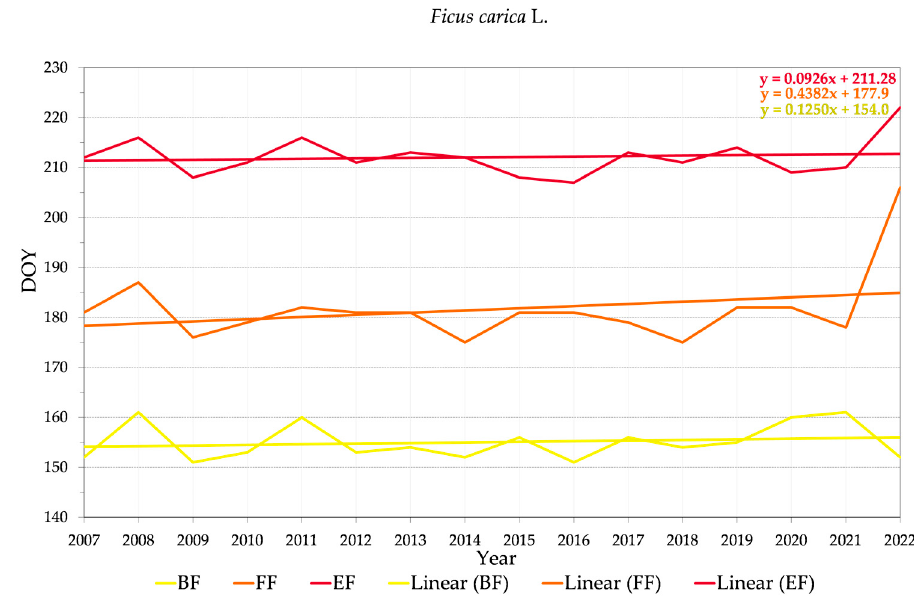
Figure 5. Linear trends of observed phenological stages for DOY in the period 2007–2022 for the beginning of flowering (BF), the period from the beginning of flowering to full flowering (BF-FF), and the period from full flowering to the end of flowering (FF-EF) for 13 woody taxa.